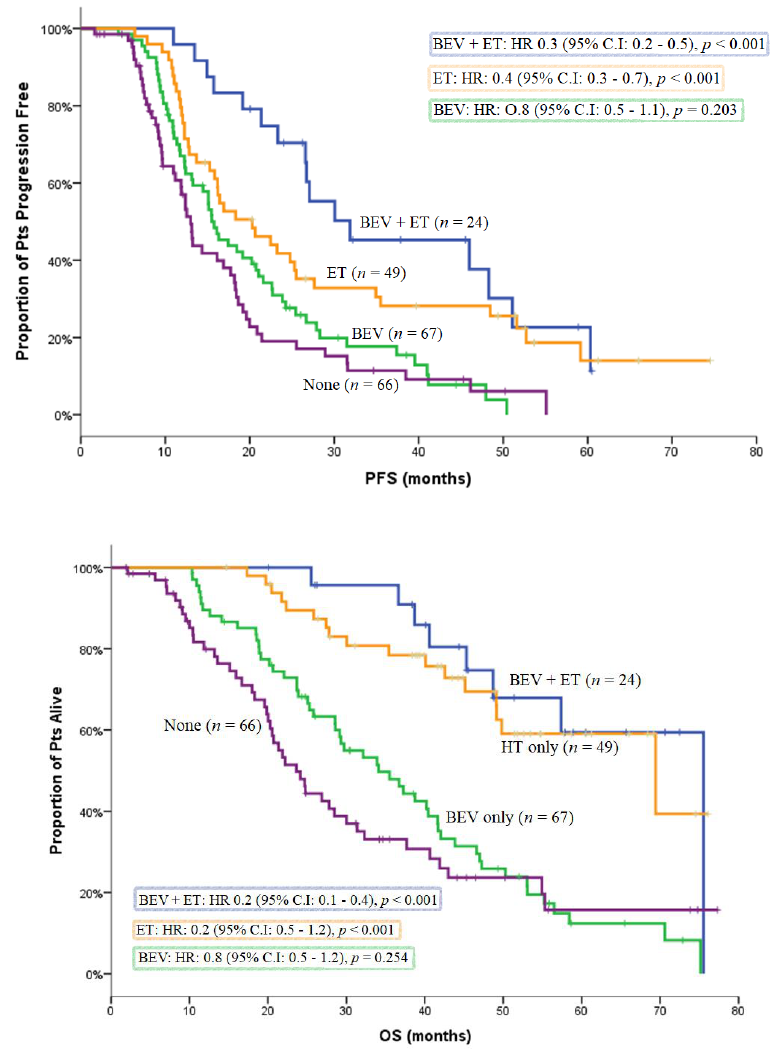
Figure 5. Kaplan–Meier curve for PFS l and OS in HR-positive patients without disease progression, according to maintenance treatment. Table 5. Maintenance treatment after completion or discontinuation of bevacizumab-based treatment in HR-negative patients without disease progression. Survival times are measured in